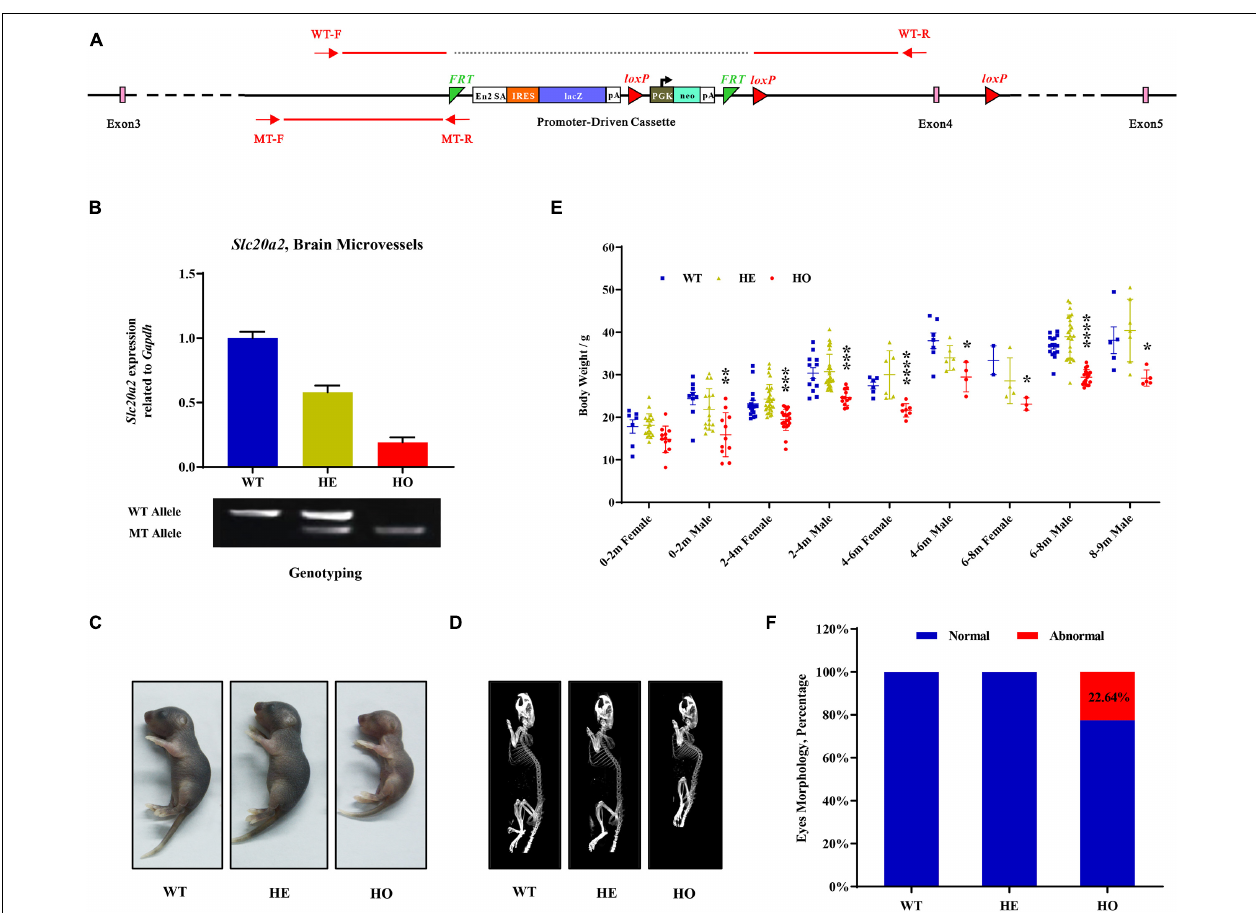
FIGURE 1 | The overall appearances of Slc20a2 -deficient mice. (A) Slc20a2 gene-trapping cassette. Red arrows and lines indicate the genotyping primer location and PCR amplicon sequence in wild (434 bp) and mutant (249 bp) alleles. (B) Slc20a2 mRNA expression in the brain microvessels of genotype-defined mice. (C) Overall appearances of 4-day-old mice. (D) Computed tomography (CT) imaging of 8 month-old mice skeleton. (E) The summary of body weight of mice with different ages, sex, and genotypes. Each symbol represents an individual. (F) The proportion of eye abnormalities in adult mice with different genotypes. * p < 0.05; ** p < 0.01; *** p < 0.001; **** p <